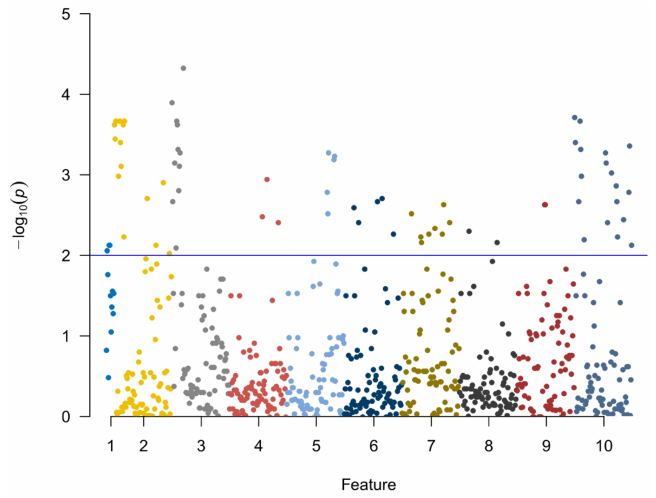
Figure 4. The p values of the 10 feature parameters and corresponding coefficients after screening in the second model are shown in this Manhattan plot.